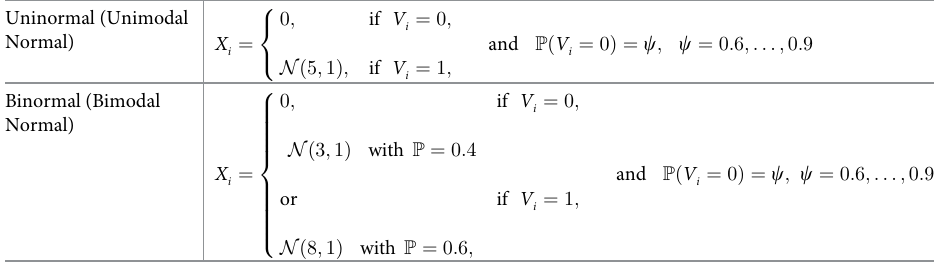
Table 1. Distribution types of X Uninormal (Unimodal Normal) X